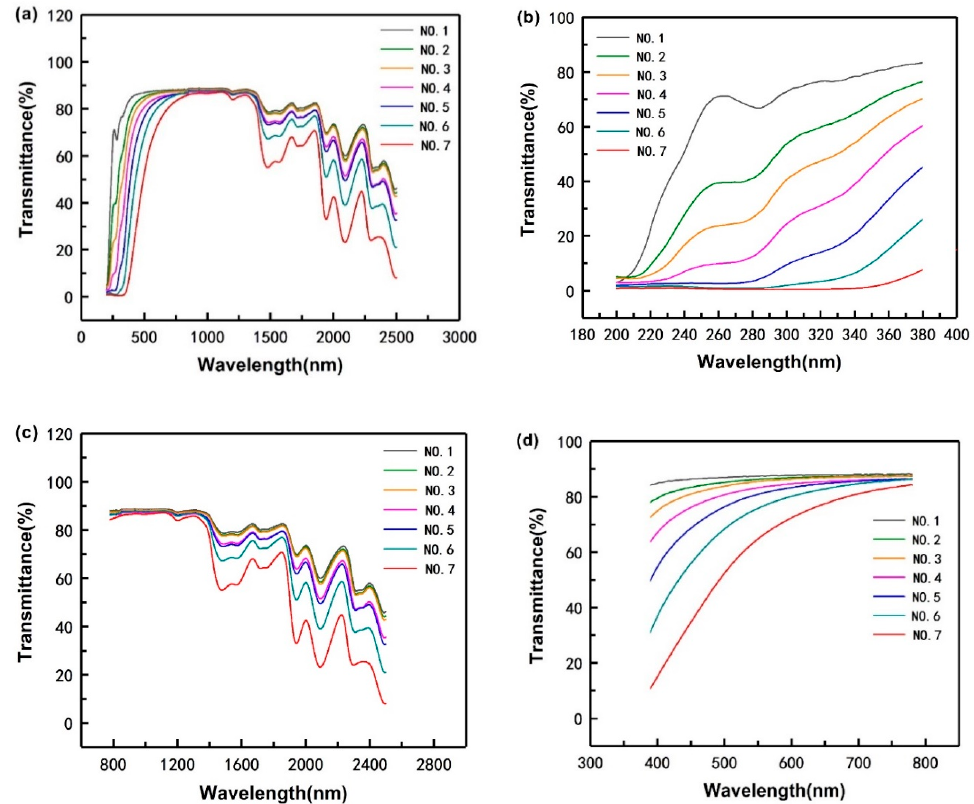
Figure 5. PVA-based composite’s light transmittance to the light at wavelength between 200 and 2500 nm ( a ); to UV light ( b ); to infrared light ( c ); to visible light ( d ). Furthermore, in order to investigate the barrier performance of the composite to light with different wavelengths, we described Figure 5a in sections according to different wavelengths, as shown in Figures 5b–d. In the range of ultraviolet light (wavelength ≤ 380 nm) and infrared light (wavelength ≥ 780 nm), compared with sample No.1 without CQDs, the transmittance of composite films with CQDs (No.2–No.7) is significantly reduced; however, in the range of visible light, introducing CQDs into PVA/CNF does not significantly enhance the barrier performance of the composite. It indicates that in PVA/CNF/CDQs films, the improvement of light resistance caused by CQDs is mainly concentrated in the ultraviolet regions. As explained in Section 3.1, CQDs have two obvious absorption peaks in the ultraviolet region, which means CQDs can absorb ultraviolet light. Therefore, with the increase of CQDs content in matrix, the UV light barrier properties of the composite are getting better and better, indicating that the greater the amount of CQDs in the PVA/CNF matrix, the more obvious the improvement of the composites’ UV light barrier.